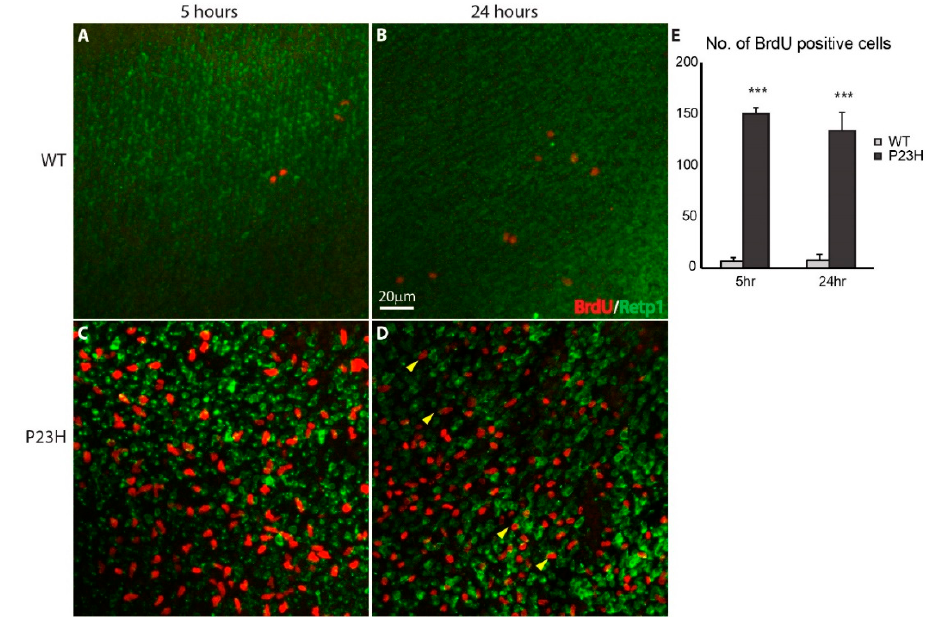
Figure 6. Continuous cell proliferation in the P23H transgenic zebrafish. Wholemount imaging of BrdU (red) labeled cells in ONL of the WT ( A , B ) and P23H transgenic ( C , D ) 5 and 24 h after BrdU injection respectively. Retp1 (green) labels rhodopsin. Yellow arrowheads in panel D show BrdU-labeled cells that co-label with Retp1, indicating their di ff erentiation into rods. Scale bar in B applies to A–D. ( E ) The number of BrdU-labeled cells in the P23H transgenic fish is significantly higher than in the WT ( n = 3 fish per genotype; error bars are ± SD; *** p <